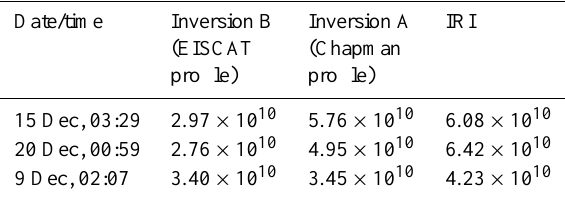
Table 2. RMS errors with respect to COSMIC occultation measure- ments (electronsm − 3